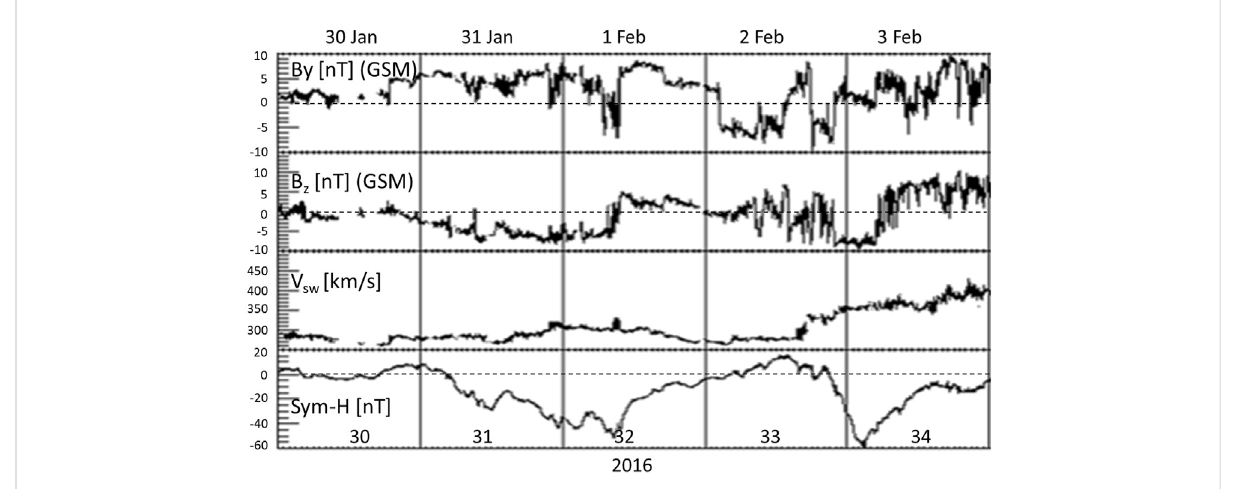
FIGURE 1 Geophysical conditions for 30 January — 3 February 2016: IMF B y (top), B z [nT] (second from top), solar wind velocity V sw [km/s] (second from bottom), and Sym-H index [nT] (bottom) based on NASA SPDF-OMNIweb data